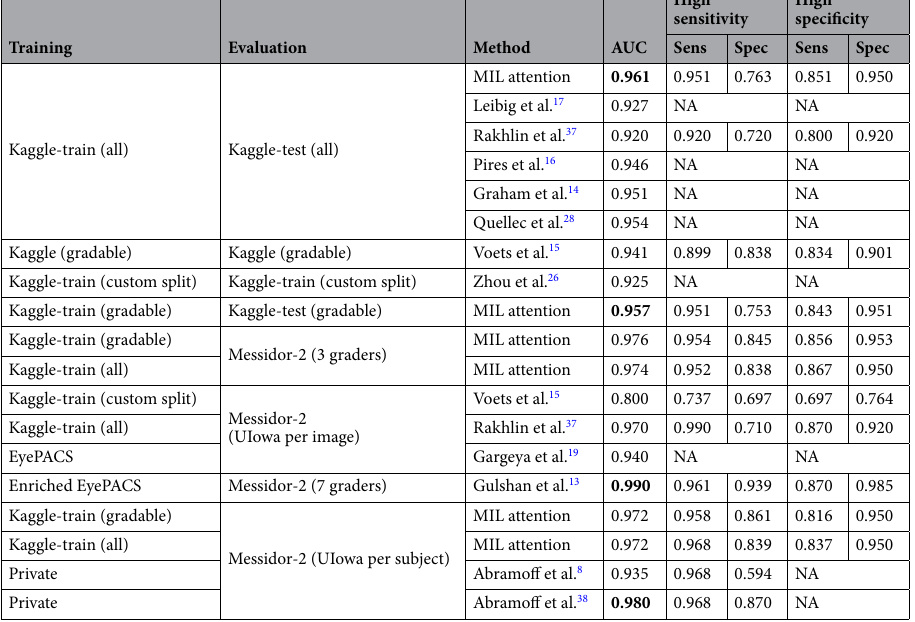
Table 2. Comparison of classification performance between the proposed approach and the most notable works in the related literature for the Kaggle-EyePACS and Messidor-2 datasets. For Kaggle we report separately methods that use the official training/test split (first part of the table) from works that use custom splits or subsets of the full set (second part of the table). Sensitivity/specificity values for the operating points of high sensitivity/specificity are reported when available. Similarly, we separate results on Messidor-2 depending on the DR grades they were obtained with. The highest AUC in each part of the table is given in